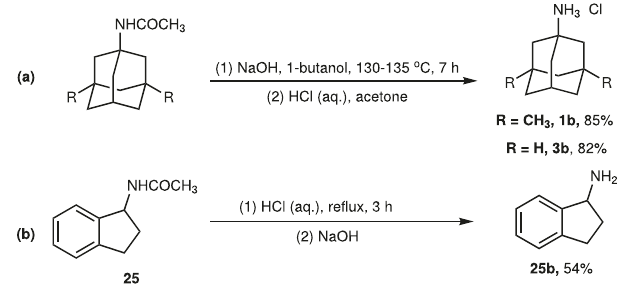
Fig. 5 Hydrolysis of amide products. a Conditions: Amide compound (3.0 mmol, 1 eq.), NaOH (24 mmol, 8 eq.), 1-butanol as solvent, 130 – 135 °C for 7 h. Then, the free base was added 5 M aq. HCl (3 mL) to give hydrochloride. b Conditions: 25 (3.0 mmol, 1 eq.), HCl (3 M, 10 eq.), re fl ux for